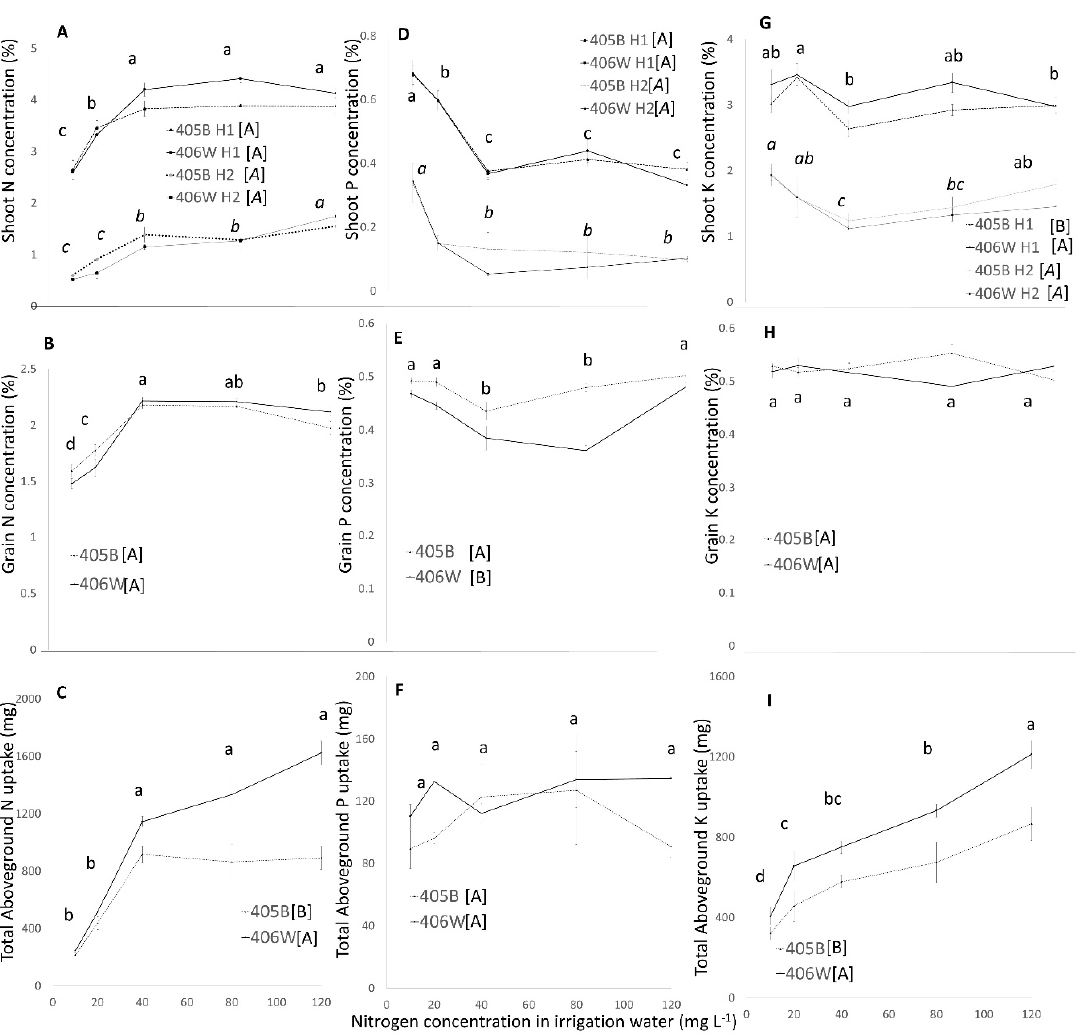
Figure 4. Shoot concentration (A, D , G ), Grain concentration ( B , E , H ), and total aboveground uptake ( C , F , I ) of N, P, K (respectively) in the winter pot experiment. Dashed line represents the 405B genotype, and solid line represents the 406W genotype. Shoot concentration ( A , E , G ) was measured two times. In parts ( A , D , G ), the first harvest (at flowering) is represented by black lines and straight letters, and the second harvest (at grain ripening) is represented by gray lines and italicized letters. Different letters represent significant (<0.05) differences for both main effects. Letters adjacent to the trend line represent the results of Tukey’s test for N concentration averaging both genotypes, and letters adjacent to the legend represent the results of the Student’s t -test for the two different genotypes.